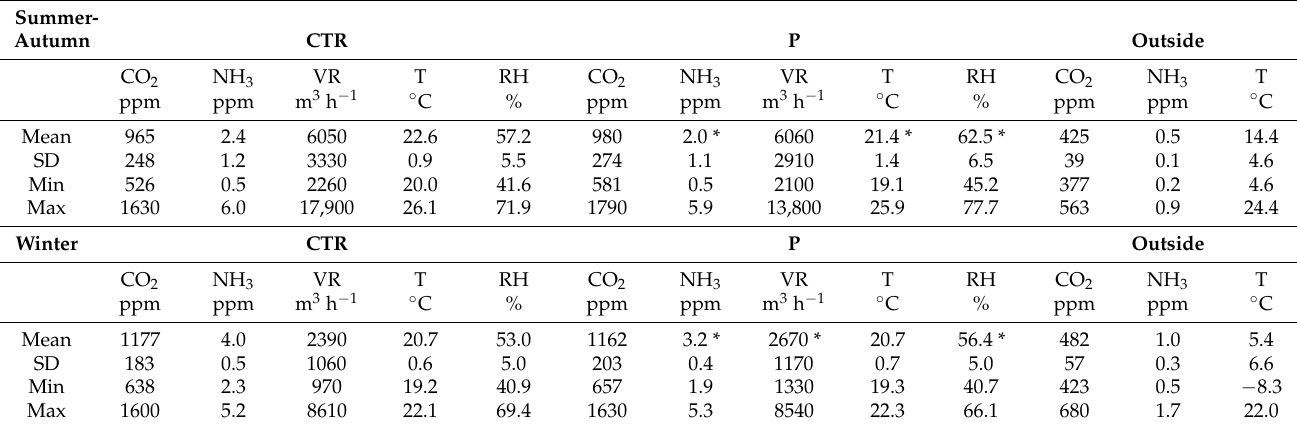
The symbol * indicates significant differences between the compartment with plants (P) and the control (CTR) ( p <